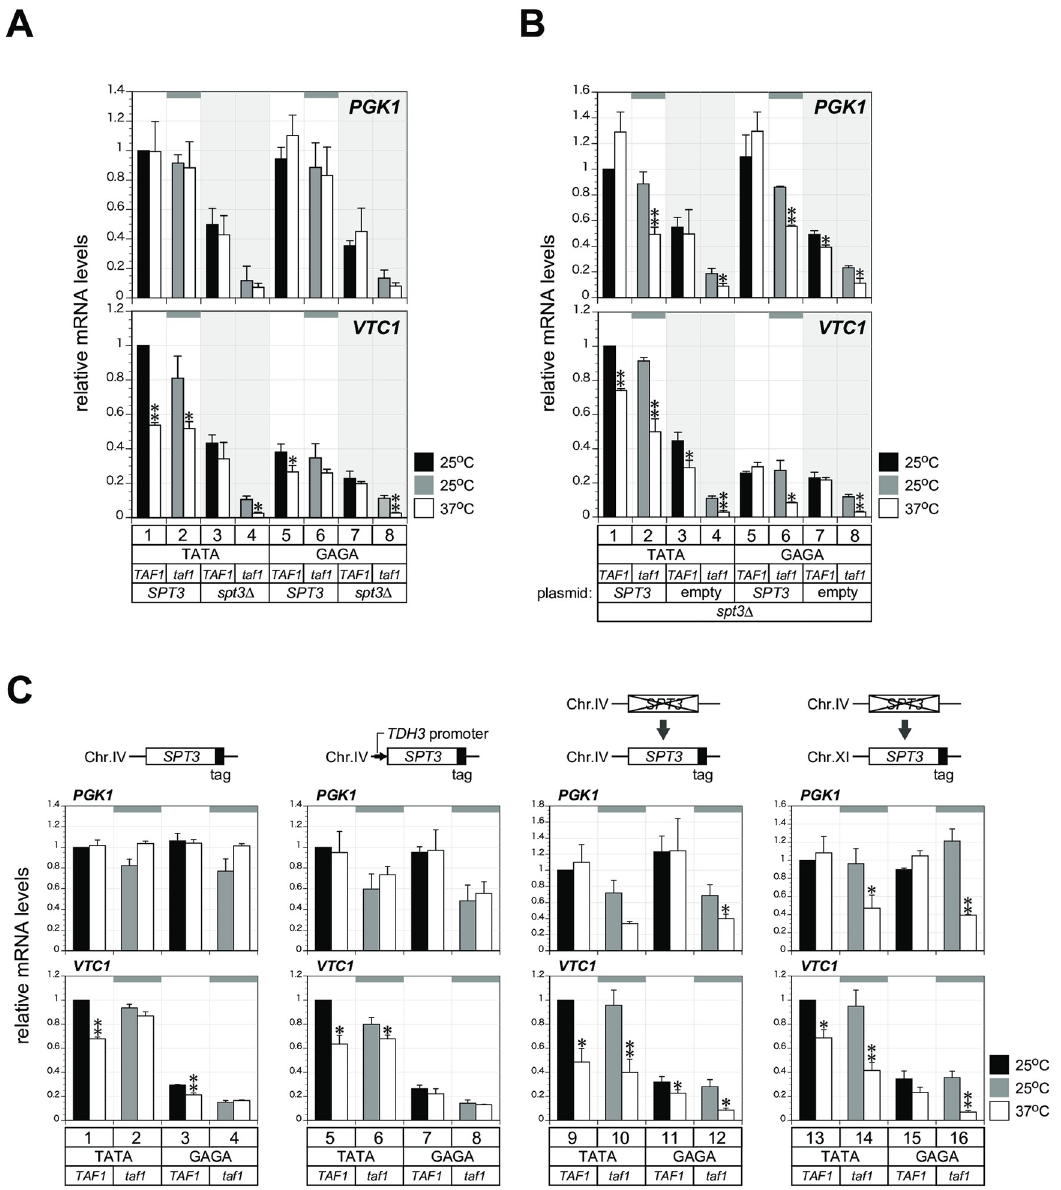
Fig 1. Taf1/TFIID dependence of PGK1 transcription is dependent on the method used for SPT3 taf1-N568 Δ strain construction. (A) RT-qPCR analyses to measure mRNA levels of PGK1 (top panel) or VTC1 (bottom panel) in the eight strains expressing the VTC1 reporter driven by the TATA box-intact PGK1 promoter (lanes 1–4) or the GAGA mutant (lanes 5–8), as indicated below the bottom panel. In these strains, chromosomal TAF1 was deleted and then substituted with plasmid-encoded TAF1 (odd-numbered lanes) or taf1-N568 Δ (even-numbered lanes), while chromosomal SPT3 was either intact (lanes 1, 2, 5, and 6) or deleted (lanes 3, 4, 7, and 8), as indicated below the bottom panel. The strains used are YTK16989 (lane 1), YTK16993 (lane 2), YTK17025 (lane 3), YTK17029 (lane 4), YTK16995 (lane 5), YTK16999 (lane 6), YTK17031 (lane 7), and YTK17035 (lane 8). Strains were cultivated at 25 º C and further incubated at 37 º C for 2 h in synthetic medium containing 2% glucose, as indicated at the right side of the VTC1 panel. mRNA levels (mean ± SD of three biological replicates) were quantified and normalized to SCR1 signal. All data are presented relative to that of lane 1 (25˚C). The significance of differences between cultivation at 25˚C and 37˚C was assessed for each strain by t-test: � p < 0.05; �� p < 0.01. Reporter VTC1 mRNA was more heat-sensitive than endogenous PGK1 mRNA, even in the wild type strain (lane 1), as already shown by Northern blot analyses in a previous study [25]. The results from spt3 Δ cells are shaded (lanes 3–4 and 7–8), while those obtained from SPT3 taf1 cells are labeled with gray bars at the top of the graph (lanes 2 and 6). (B) RT-qPCR analyses to measure mRNA levels of PGK1 (top panel) or VTC1 (bottom panel) in the eight strains carrying the VTC1 reporter driven by the PGK1 promoter, in which the TATA box was intact (lanes 1–4) or substituted with the GAGA sequence (lanes 5–8), as indicated below the bottom panel. In these strains, chromosomal TAF1 was deleted and substituted with